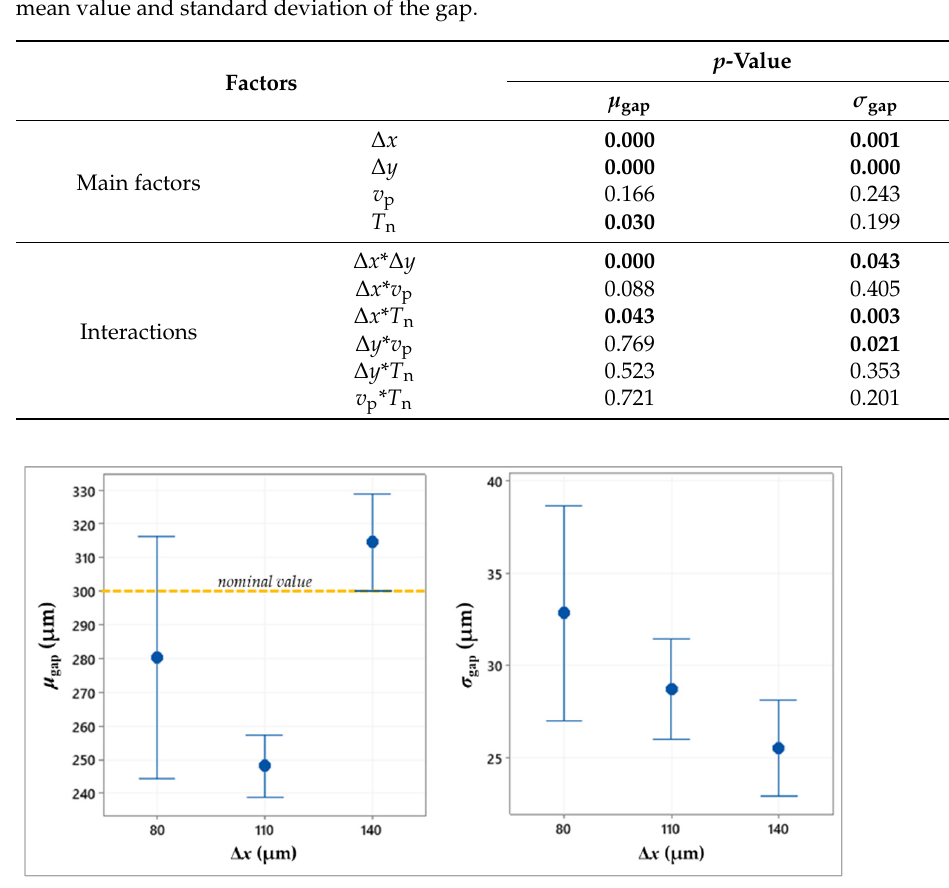
Figure 5. Interval plot of the mean value and standard deviation of the gap against drop spacing along the x-axis.